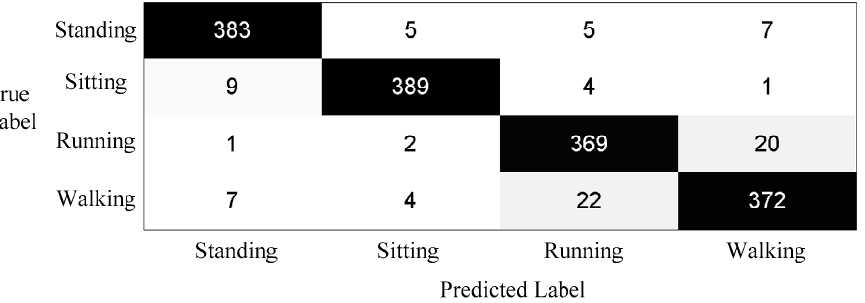
Figure 10. Summed confusion matrix results of motion sensor.